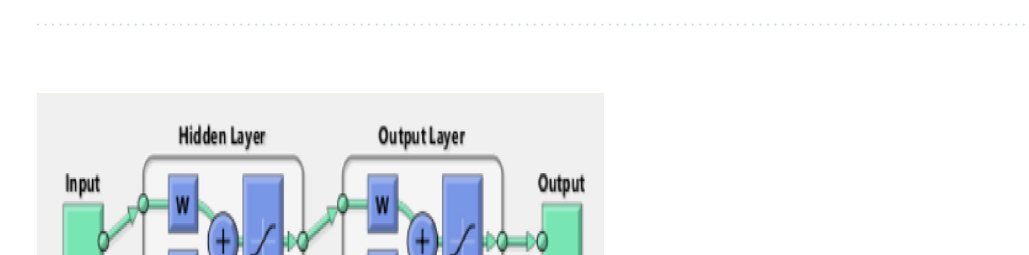
Table 3. Neural network construction.